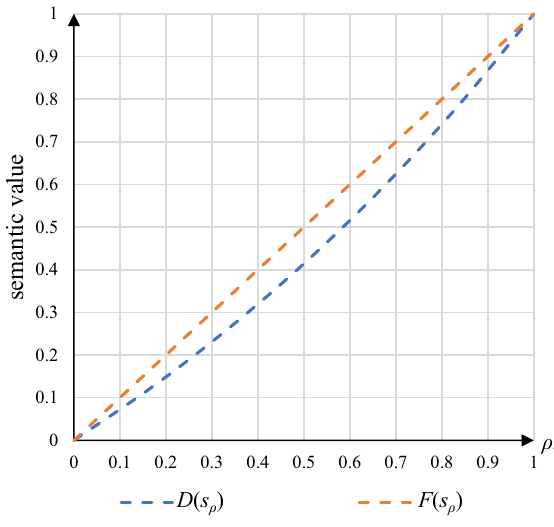
Fig. 2 The linguistic term and its corresponding semantic value